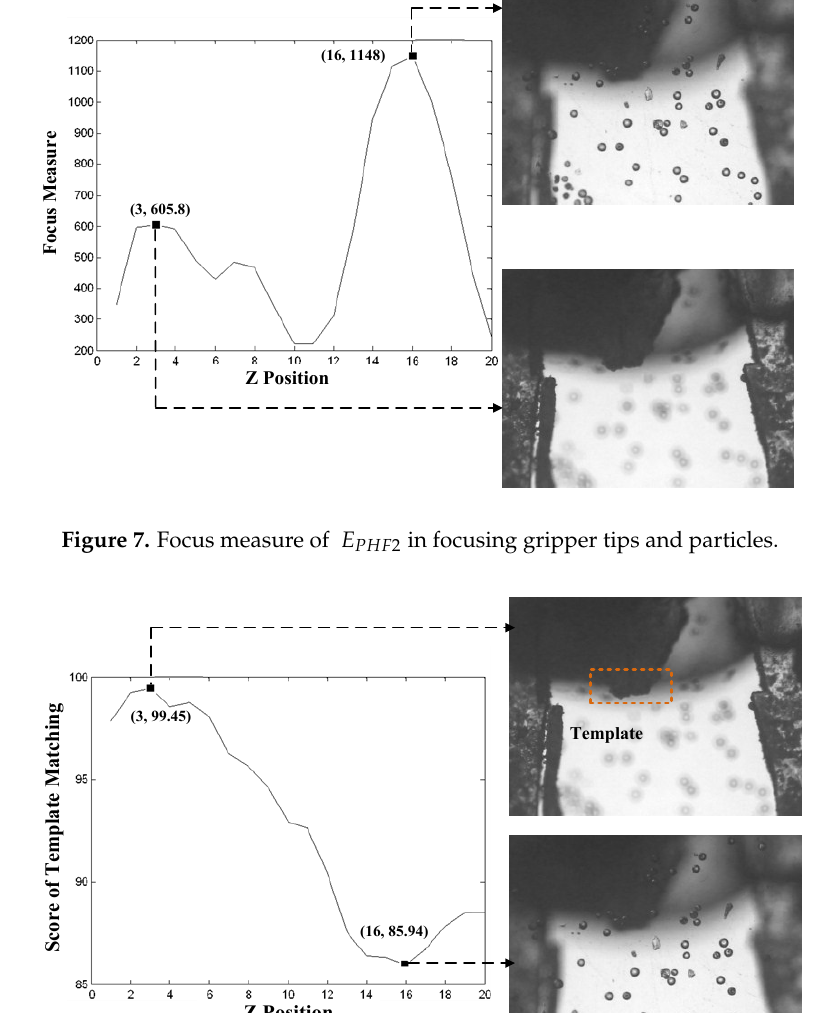
Figure 8. Score of template matching by employing the template of gripper tips.